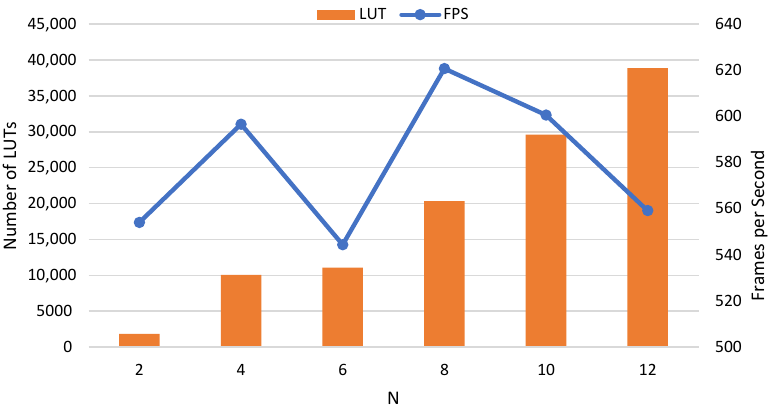
Figure 9. Resource occupation of the accelerator for the inference of the proposed model with a variable number of filters with the CIFAR-10 dataset on a ZYNQ7020 with a frame rate around